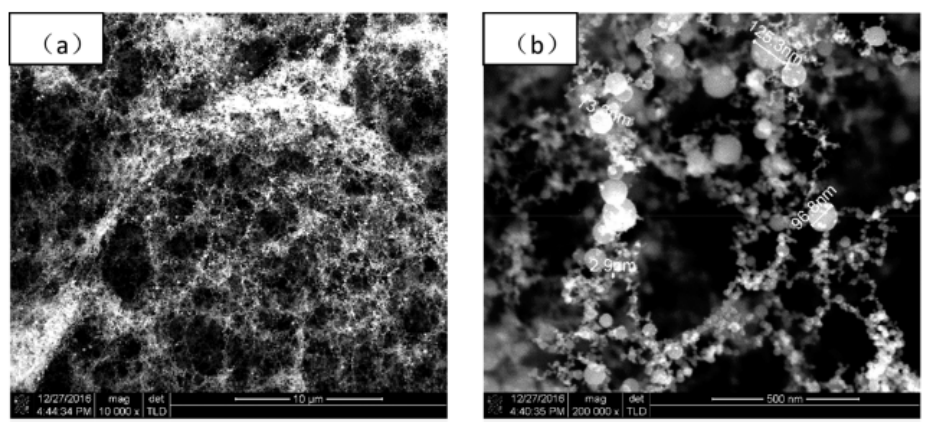
Figure 3. FESEM images of a TiO 2 film deposited in air: ( a ) 10,000 × magnification; ( b ) 200,000 × magnification. Reprinted with permission from [70]. Copyright from 2017 AIP Publishing.